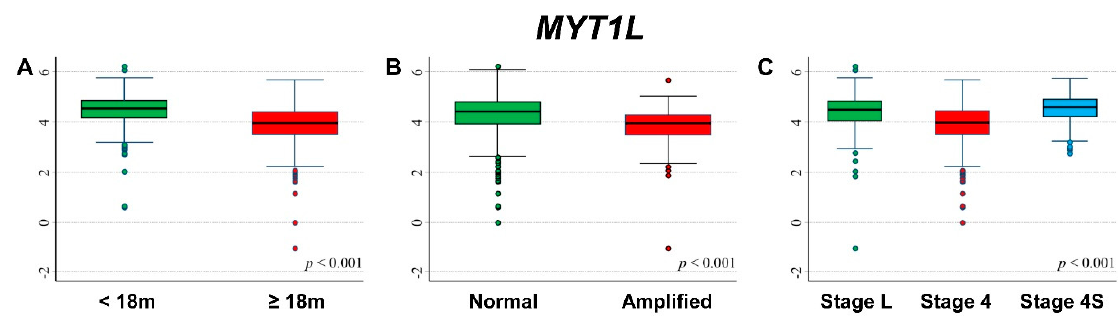
Figure 4. Association between MYT1L gene expression and the main patient characteristics at diagnosis. ( A ) Age; ( B ) MYCN status; ( C ) Stage.